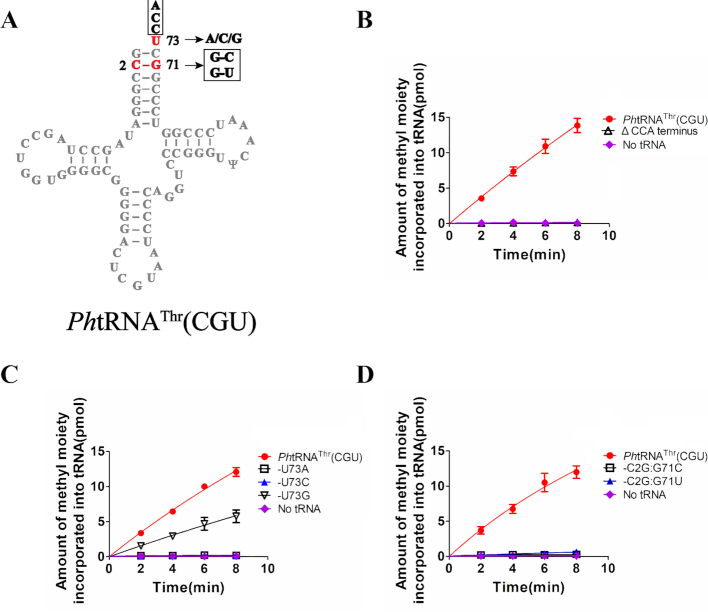
Recognition elements of PhtRNA in the acceptor region by PhNSun6. (A) The secondary structure of PhtRNAThr(CGU) summarizing the mutations in the acceptor region. (B) The capacity of PhtRNAThr(CGU) mutant lacking CCA terminus to be methylated by PhNSun6. (C) The capacity of PhtRNAThr(CGU) with various mutations at position 73 to be methylated by PhNSun6. (D) The capacity of PhtRNAThr(CGU) with several mutations in C2:G71 base pair to be methylated by PhNSun6.